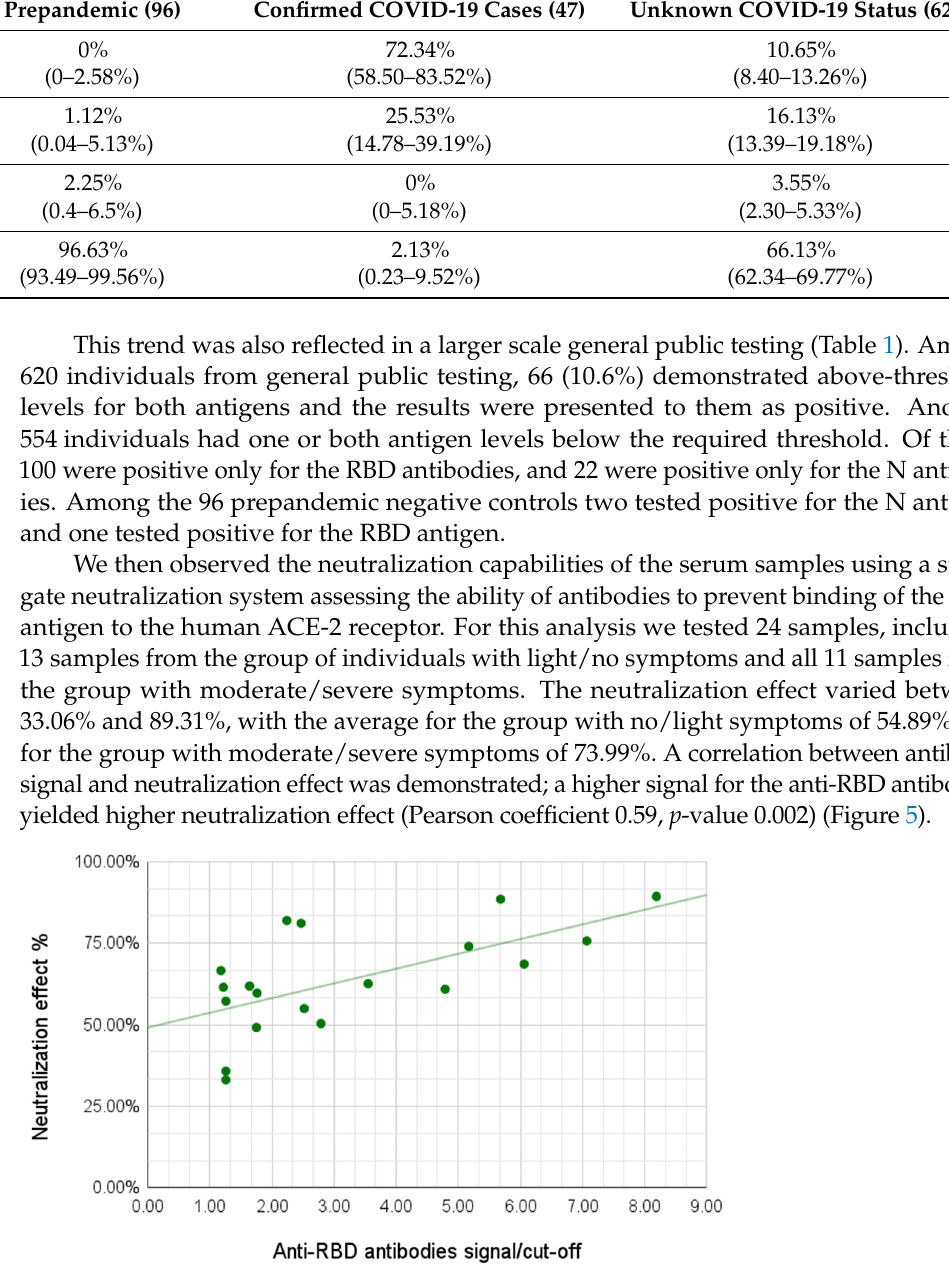
Figure 5. Correlation of anti-RBD antibody signal with ACE-2 neutralization effect (R 0.59).